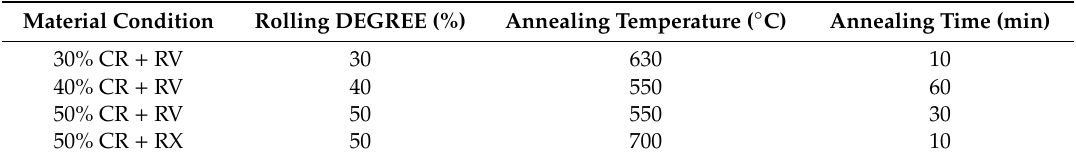
Table 1. Cold rolling degree and heat treatment parameters for recovery annealing and recrystallization. CR: cold rolled; RV: recovery; RX: recrystallized.